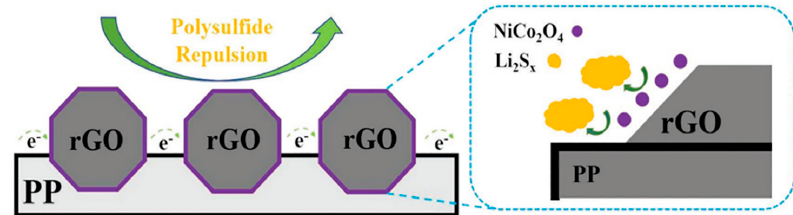
Figure 5. Schematic of the NiCo 2 O 4 @rGO / PP when recharging. Reprinted with permission from [83]. Copyright (2019) WILEY-VCH.